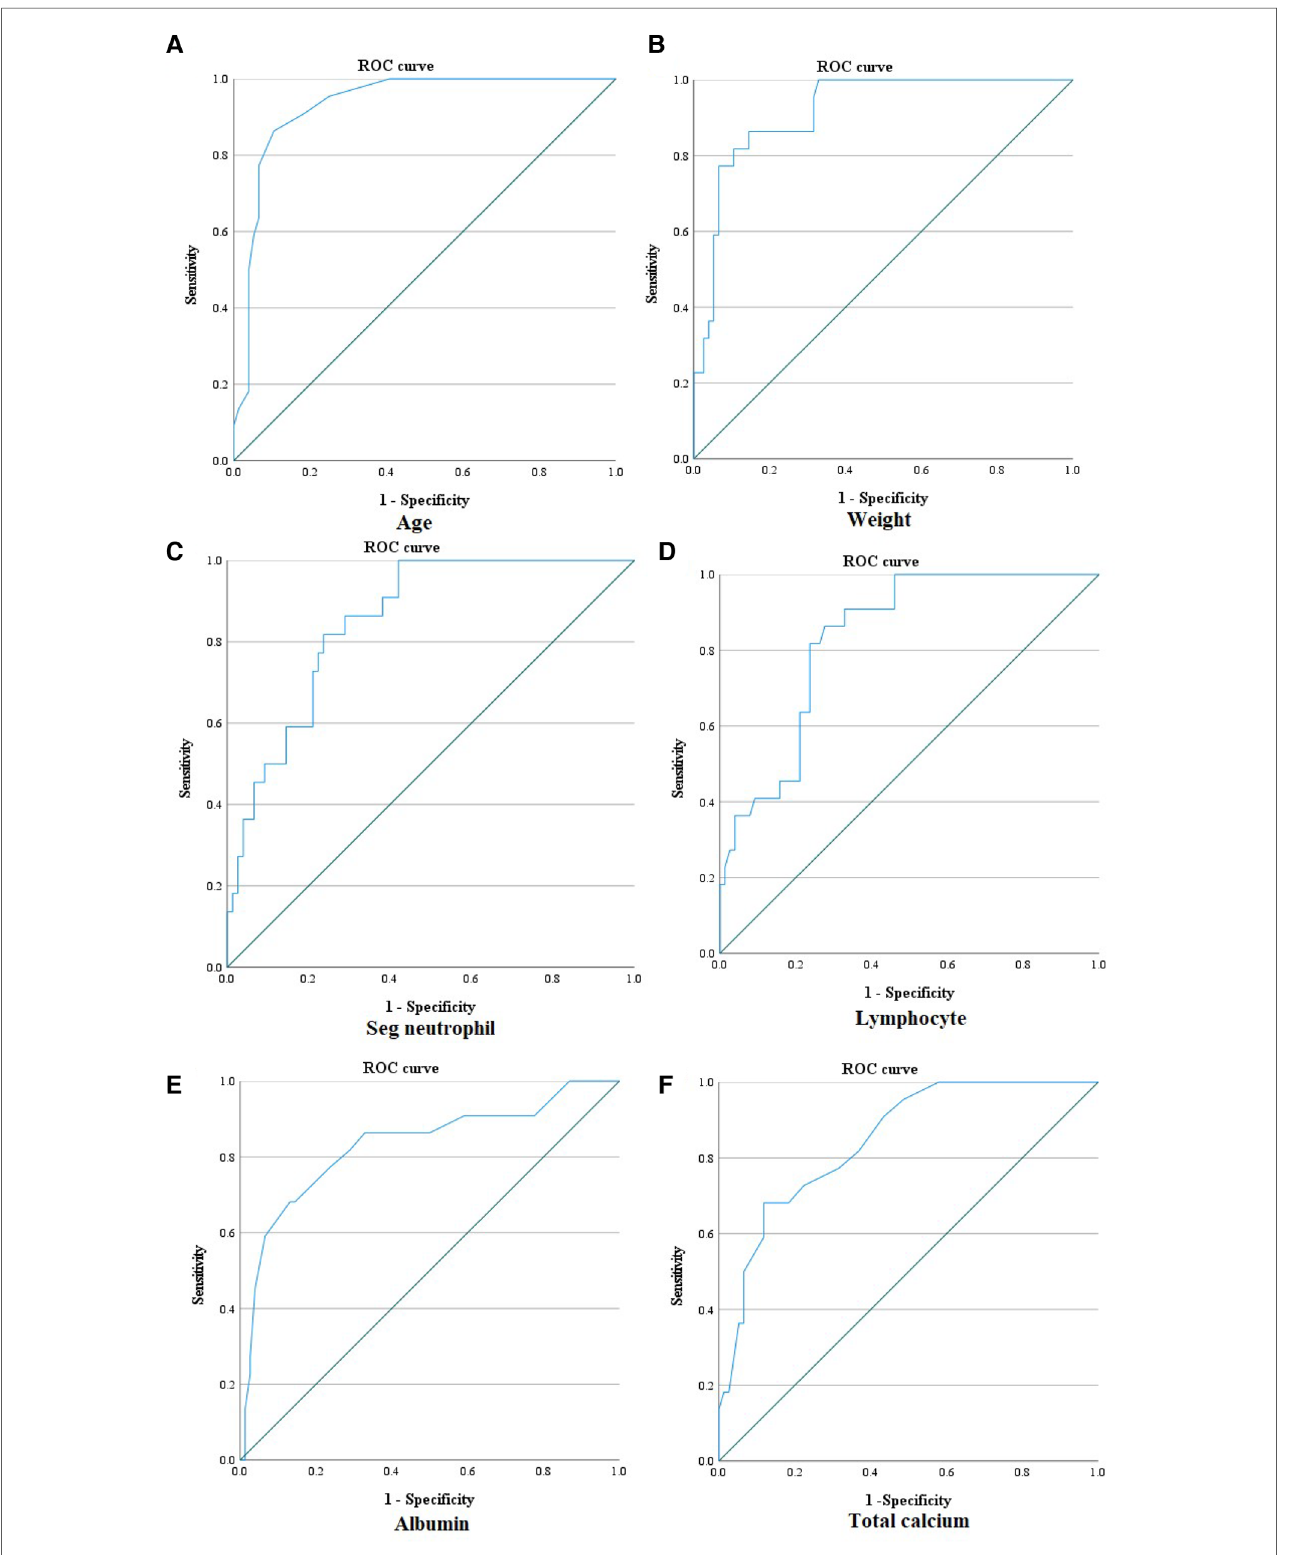
FIGURE 2 ROC curve of age, weight, segmented neutrophil percentage, lymphocyte percentage, albumin, and total calcium for diagnosing MIS-C. ( A ) ROC curve of age for diagnosing MIS-C [AUC: 0.931 (0.880 – 0.982); ≥ 4.5 years old: sensitivity 86.4%, speci fi city 89.5%]. ( B ) ROC curve of weight for diagnosing MIS-C [AUC: 0.917 (0.860 – 0.974); ≥ 16.75 kg: sensitivity 86.4%, speci fi city 85.5%]. ( C ) ROC curve of segmented neutrophil percentage for diagnosing MIS-C [AUC: 0.852 (0.775 – 0.929); ≥ 70.1%: sensitivity 81.8%, speci fi city: 76.3%]. ( D ) ROC curve of lymphocyte percentage for diagnosing MIS-C [AUC: 0.833 (0.752 – 0.915); ≤ 21.8%: sensitivity 81.8%, speci fi city 76.3%]. ( E ) ROC curve of albumin for diagnosing MIS-C [AUC: 0.830 (0.721 – 0.939); ≤ 3.85 g/dl: sensitivity 77.3%, speci fi city 76.3%]. ( F ) ROC curve of total calcium for diagnosing MIS-C [AUC: 0.846 (0.762 – 0.930); ≤ 9.25 mg/dl: sensitivity 72.7%, speci fi city 77.6%]. ROC curve, receiver operating characteristic curve; AUC, area under the